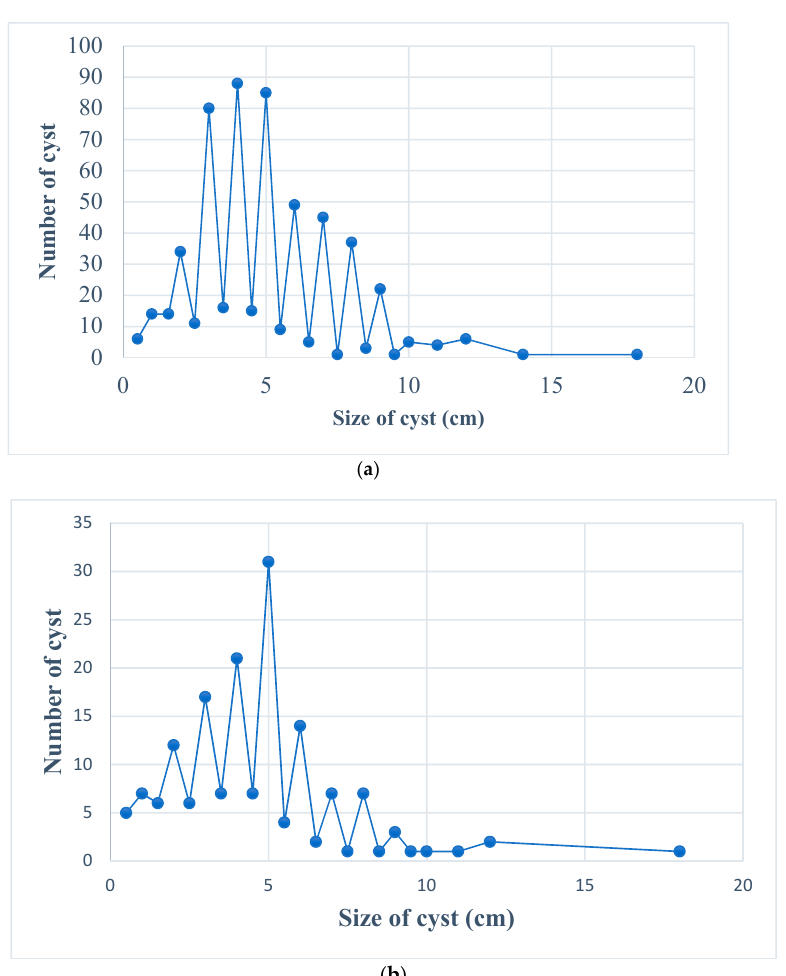
Figure 2. Variation in cyst size, ( a ). all cyst, ( b ). fertile cyst. As dogs are one of the major sources of human CE, the slaughterhouses were in- spected for possible risk factors for parasite transmission. According to the data from the second questionnaire, there is a considerable risk of local dogs becoming infected due to the lack of hygiene, education, and control in the three slaughterhouses of Rawalpindi (Table 4).